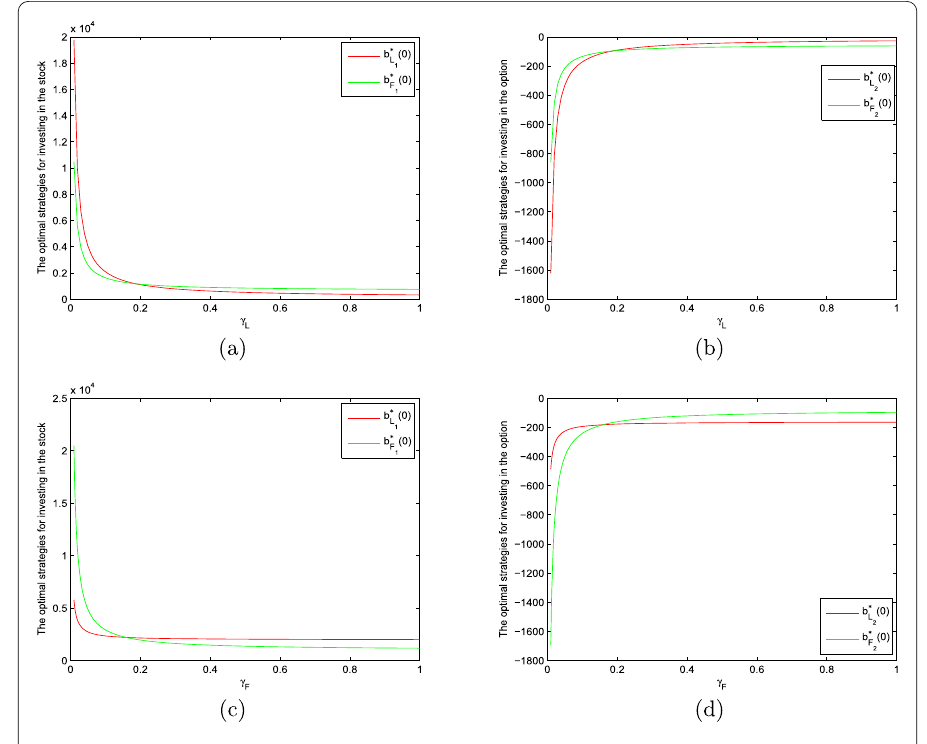
Figure 1 Sensitivities of optimal investment strategies to risk aversion coefficients